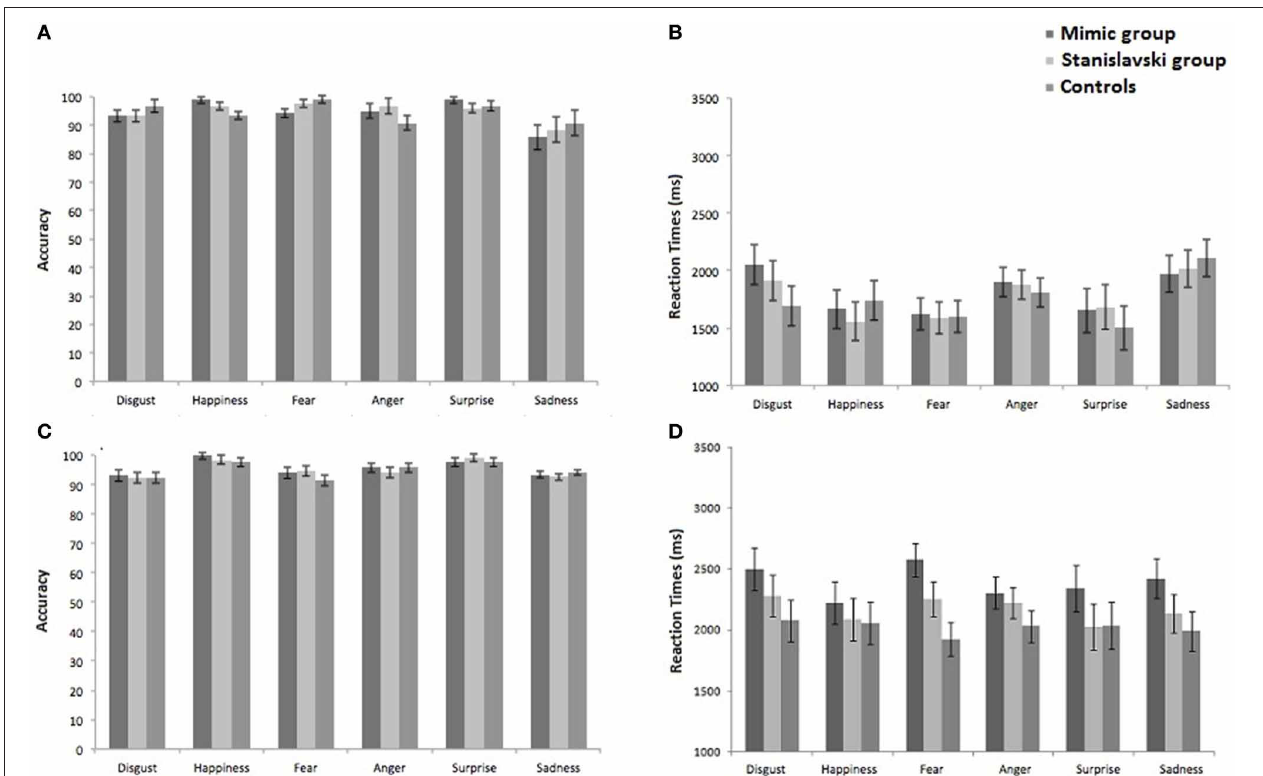
FIGURE 3 | Percentages of correct responses and RTs (bars represents SEM) plotted against the six emotions in the three groups, separately for target-present trials (A and B) and target-absent trials (C and